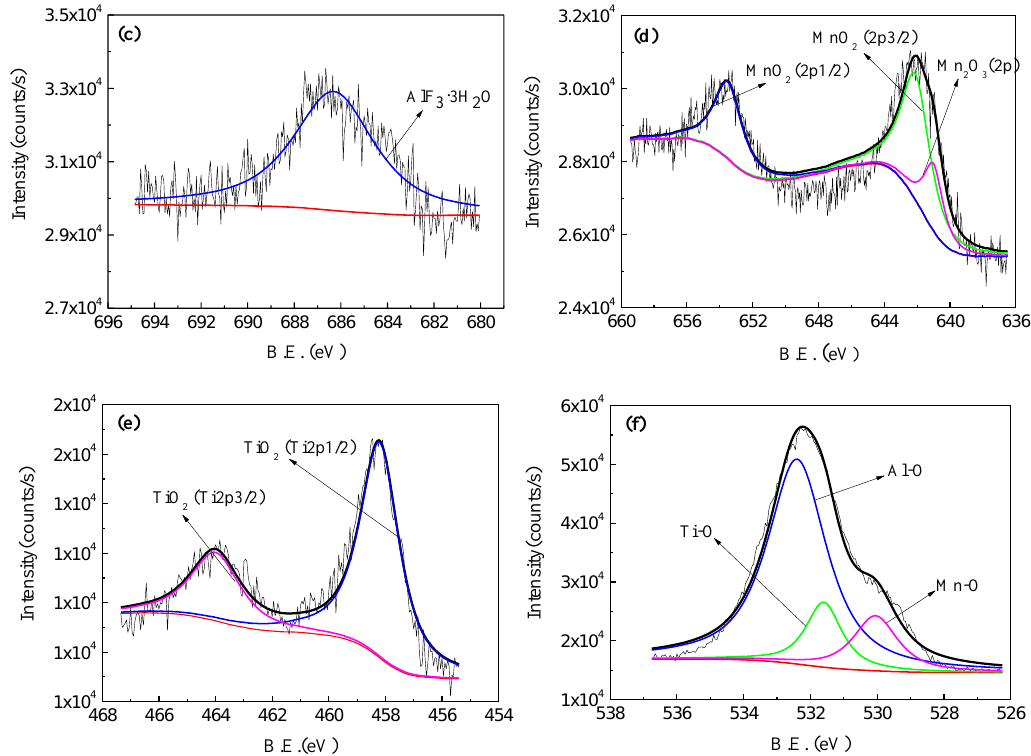
Figure 4. XPS spectra of conversion-coated 5052 aluminum alloy: ( a ) the wide-scan spectrum, ( b ) Al2p spectrum, ( c ) F1s spectrum, ( d ) Mn2p spectrum, ( e ) Ti2p spectrum, and ( f ) O1s spectrum.